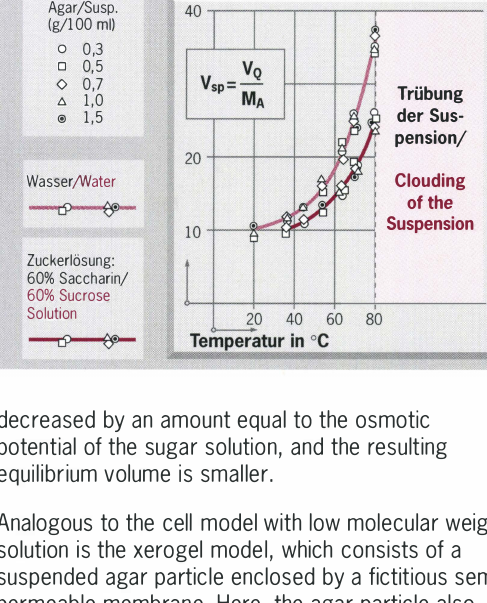
Swelling in a standing cylinder after